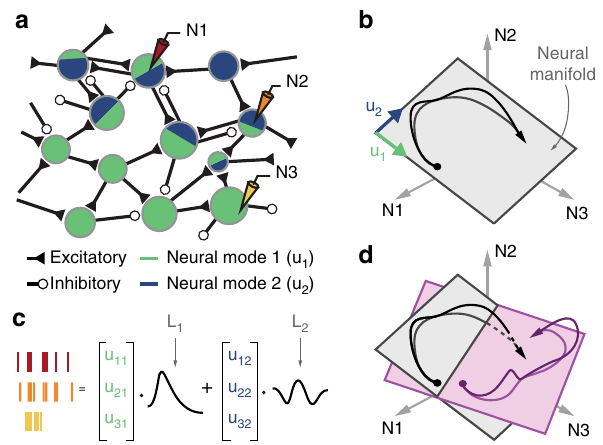
Fig. 1 Hypothesis: varied motor behaviors are caused by the fl exible activation of combinations of neural modes. a The connectivity of the cortical network results in neural modes whose combined activity explains the speci fi c activity of individual neurons. b The neural space for the three neurons recorded in a . The time-dependent population activity is represented by a trajectory (in black, arrow indicates time direction) mostly con fi ned to a two-dimensional neural manifold (gray plane) spanned by two neural modes (green u 1 and blue u 2 basis vectors). c The time-dependent activity of each recorded neuron is a weighted combination of the latent activities L 1 and L 2 , each the time-dependent activation of the corresponding neural mode. d Do neural manifolds for different tasks (shown in gray and light purple) have similar orientation? Are the latent activities for the two tasks (shown in black and purple) similar? These are the two critical questions to test our